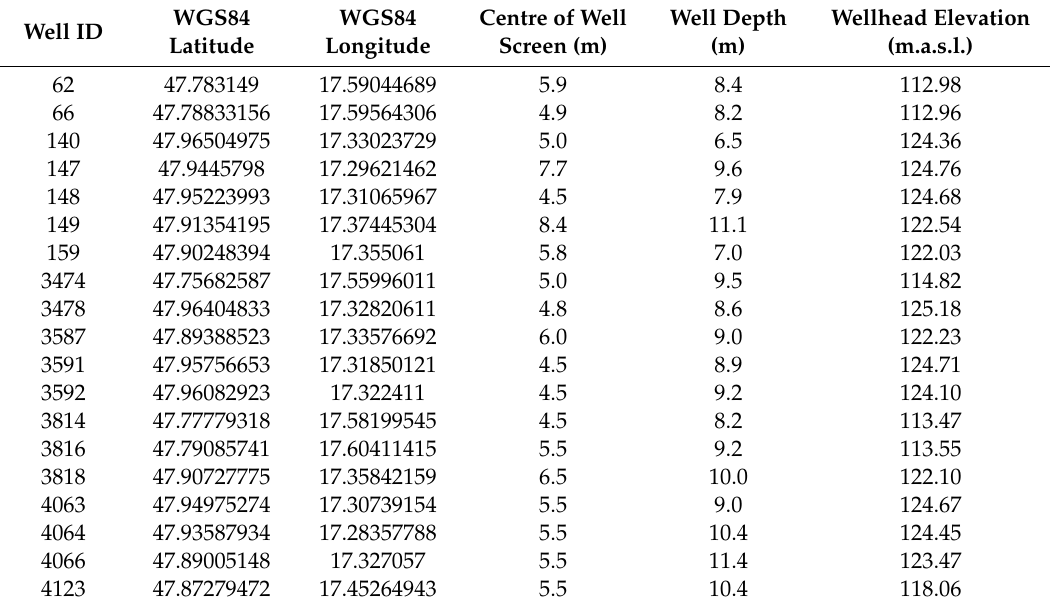
Table A1. Metadata of wells